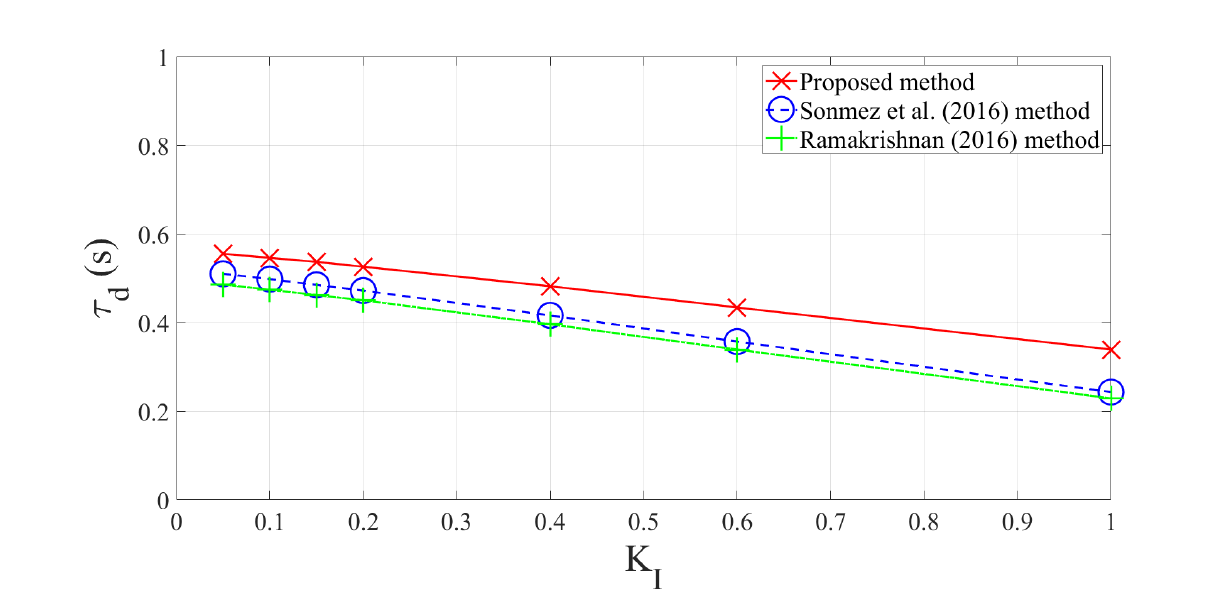
Figure 9. With K P = 1.0, the DM, τ d , is shown against the integral gain, K I , curve [18,28]. Case study 1 with K P = 0.2 and K I = 0.4: The DM estimated using the method pro- vided in [18] is 3.631 s, while it was 3.641 s with the proposed method. The proposed method, just like the method described in [18], gives precise DM values. Simulations with Matlab/Simulink are performed to validate the results. Figures 10 and 11 showcase the frequency response of a two-area LFC system when subjected to different time delay values in area 1 and area 2, while utilising K P = 0.2 and K I = 0.4. At 10 s, the load changes, ( ∆ P d 1 = ∆ P d 2 ), by 0.1 p.u. Figures 10 and 11 depict the frequency response with time delay, τ , of 3.5 s, 3.641 s, and 3.7 s, for area 1 and area 2, respectively. It is obvious that the system is stable with τ = 3.5 s and unstable with τ = 3.7 s. Meanwhile, the system is marginally stable with τ = 3.641 s.